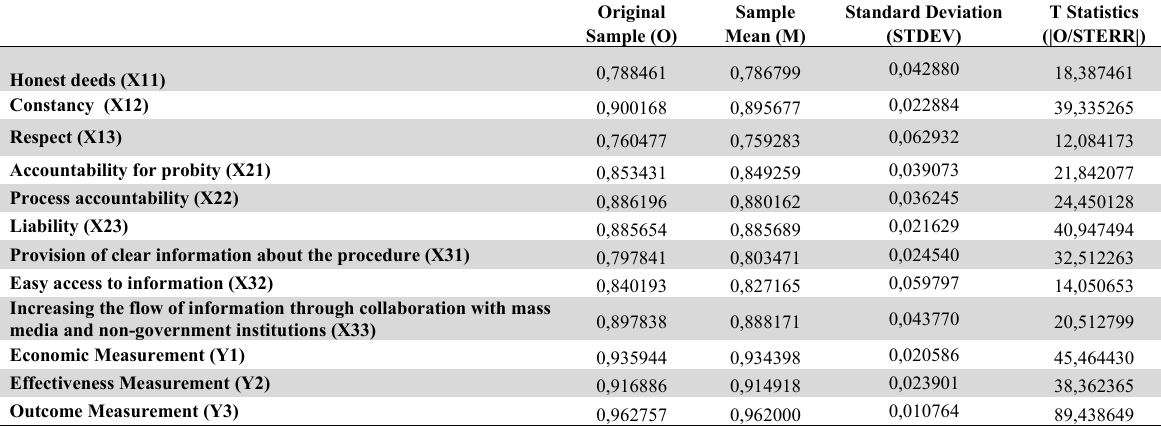
Outer Loadings (Mean, STDEV, T-Value)